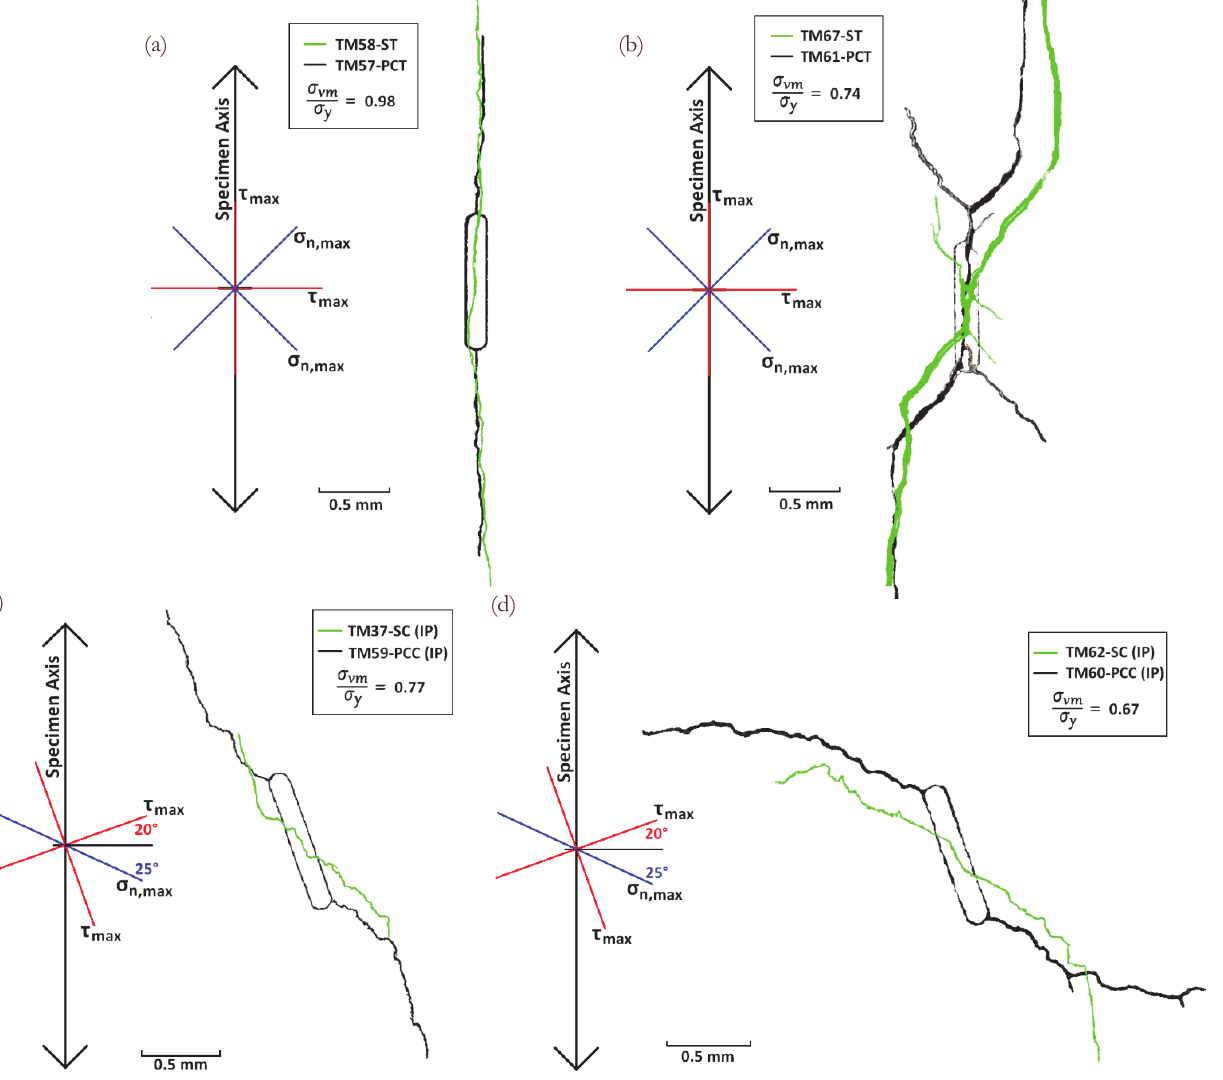
Figure 2: Superimposed crack paths for precracked specimens (black) and smooth specimens (green) tested under identical loading conditions for (a) higher load level pure torsion, (b) lower load level pure torsion, (c) higher load level in-phase axial torsion, and (d) lower load level in-phase axial-torsion tests. Relative load level is indicated by the ratio of von Mises equivalent stress to yield